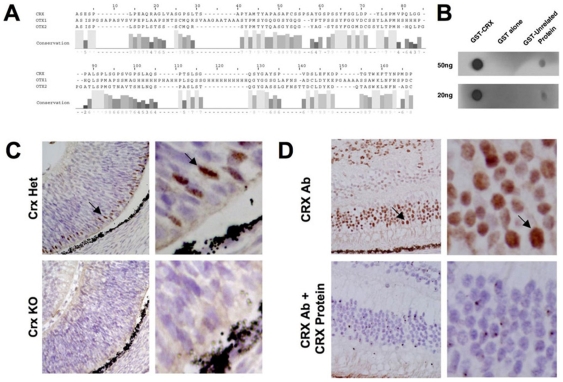
Validation of antibody specificity.Sequence alignment (Smith-Waterman) of human CRX immunogen (amino acids 166 to 285) with OTX1 and OTX2 (A) demonstrates low identity for the relevant epitope (<40%). Residue number 1 correpsonds with residue 166 of CRX. AMAS conservation scores are listed below the alignment. Immunoblot of native, non-denatured GST-Crx, GST alone and with the unrelated protein GST-Cry1 demonstrates robust specificity of the H120 antibody for native Crx (B). Immunohistochemical analysis using the H120 anti-Crx antibody demonstrates strong reactivity in the developing retina of E14.5 mice, which are heterozygous for Crx (Crx +/−), while the signal is absent in the retina of Crx knockout mice (Crx −/−) (C). Competition assays with CRX protein on tissue sections of human retina and retinoblastoma (cells at top of image) demonstrate the immunoreactivity of the H120 anti-Crx antibody is specifically competed away with 1∶1 molar amounts of purified GST-Crx protein in normal and tumor cells.